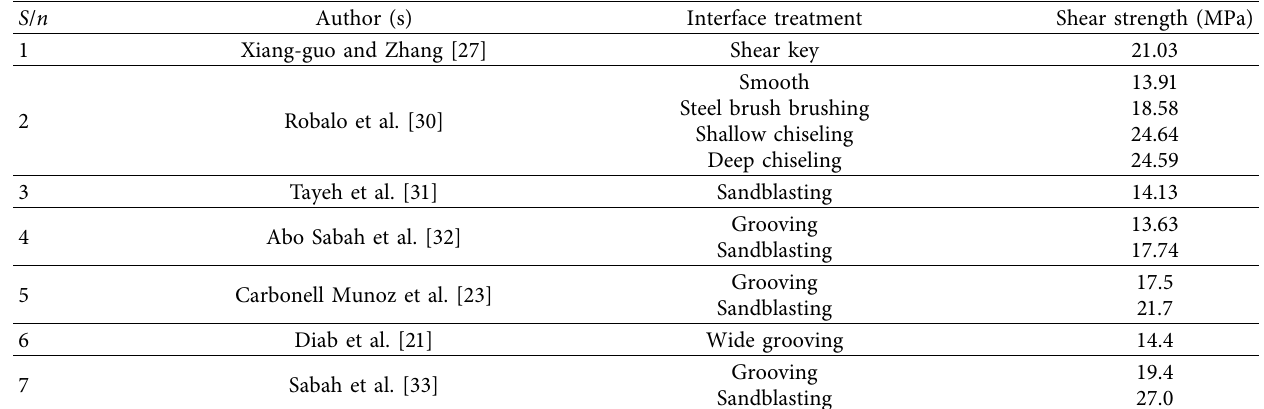
Table 6: 30 ° slant shear strength of other